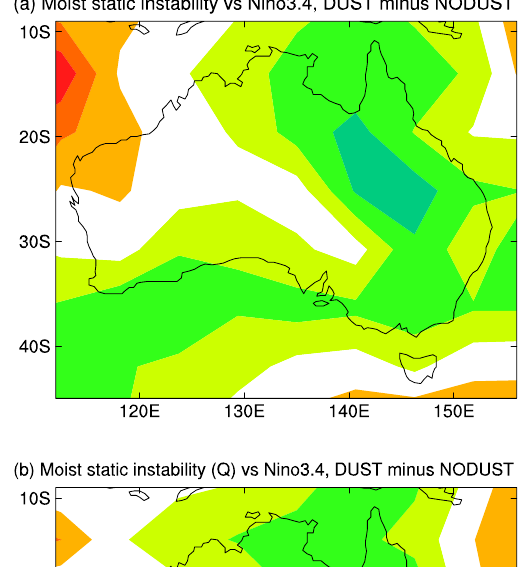
Fig. 8. Differences in the vertical profile of moist static energy, averaged over the stippled points in eastern Australia from Fig. 6: DUST minus NODUST (black), El Ni˜no minus neutral for DUST (red) and NODUST (magenta), La Ni˜na minus neutral for DUST (blue) and NODUST (green).